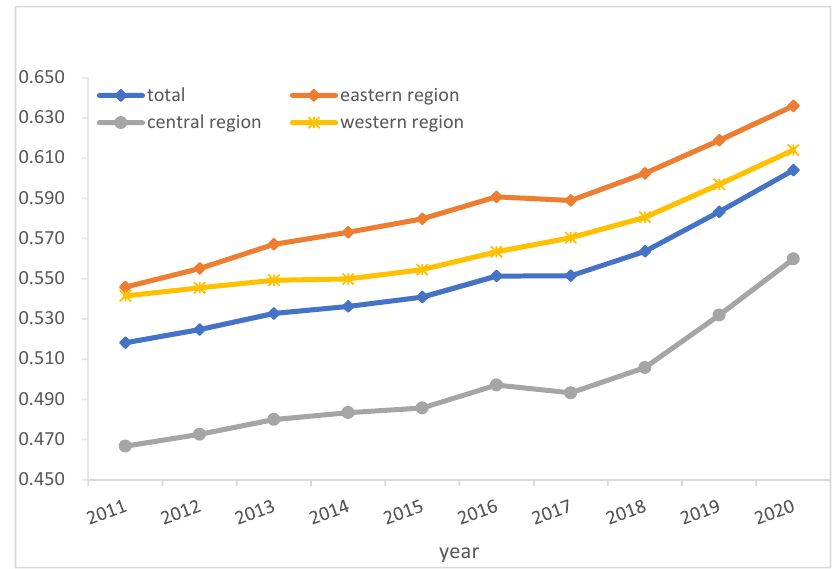
Figure 6. Trend of regional agricultural green production level.